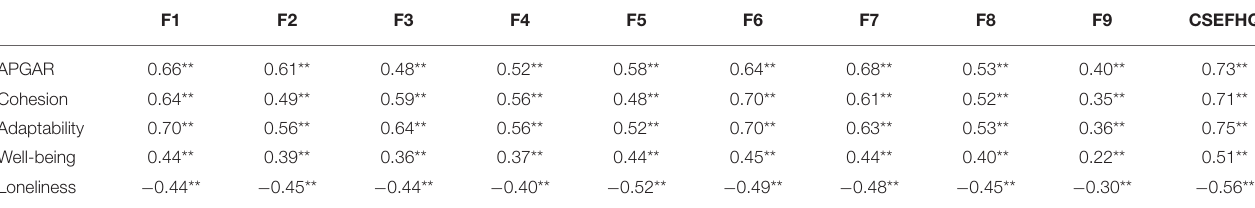
TABLE 5 | Correlation coefficients between factors and criteria of the CSEFHQ ( N = 519). F1